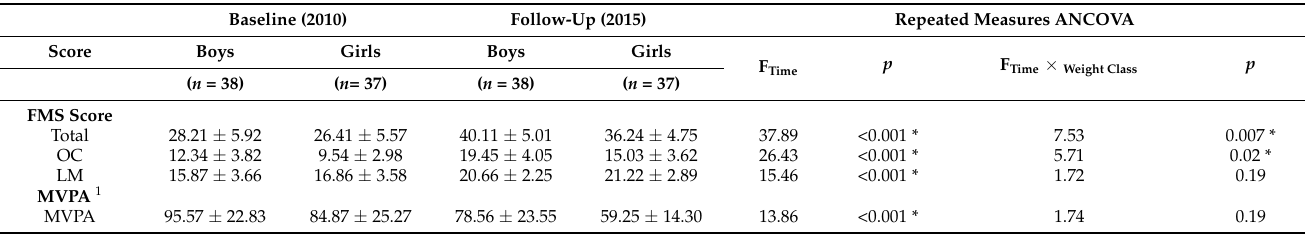
Table 2. Means, standard deviations and summary of repeated measures analysis for FMS compe- tency scores and MVPA for non-overweight and overweight/obese participants.